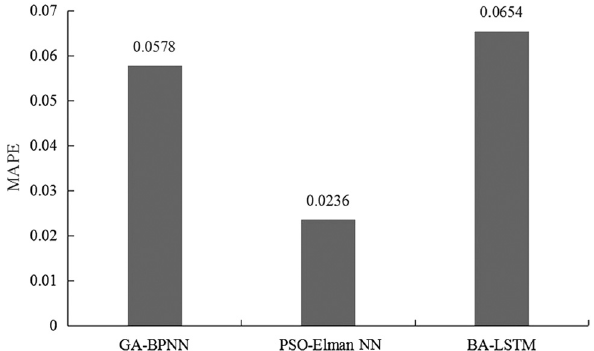
Figure 2: Comparison of MAPE values between di ff erent models.